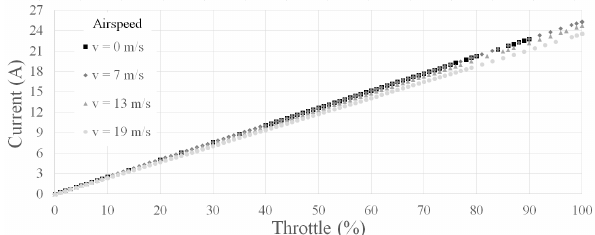
Figure 10. Current-throttle for different